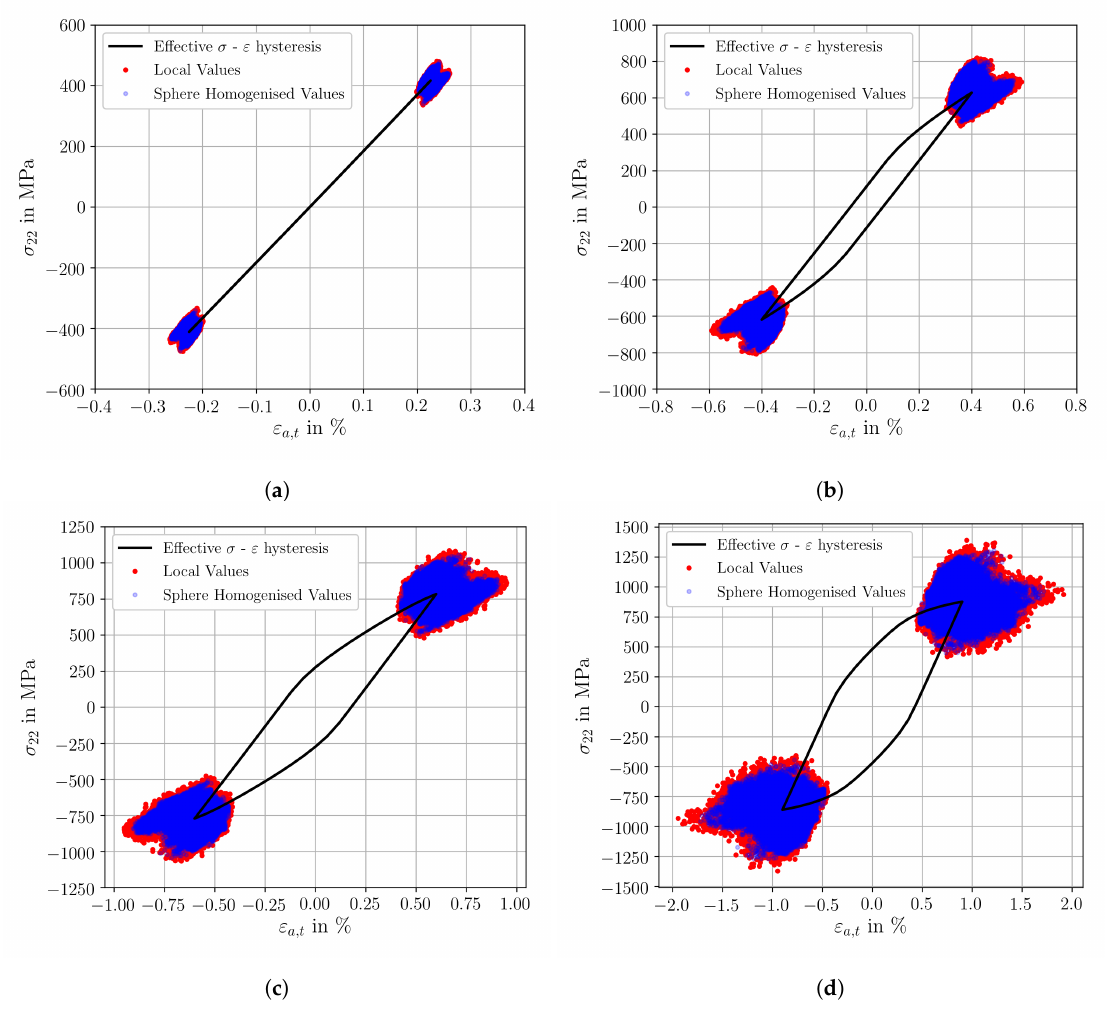
Figure 7. Effective cyclic stress-strain hystereses, local integration point values of stress and strain (red markers) and corresponding sphere homogenised values of stress and strain (blue markers), for ( a ) ε a , t = 0.225%, ( b ) ε a , t = 0.40%, ( c ) ε a , t = 0.60% and ( d ) ε a , t =